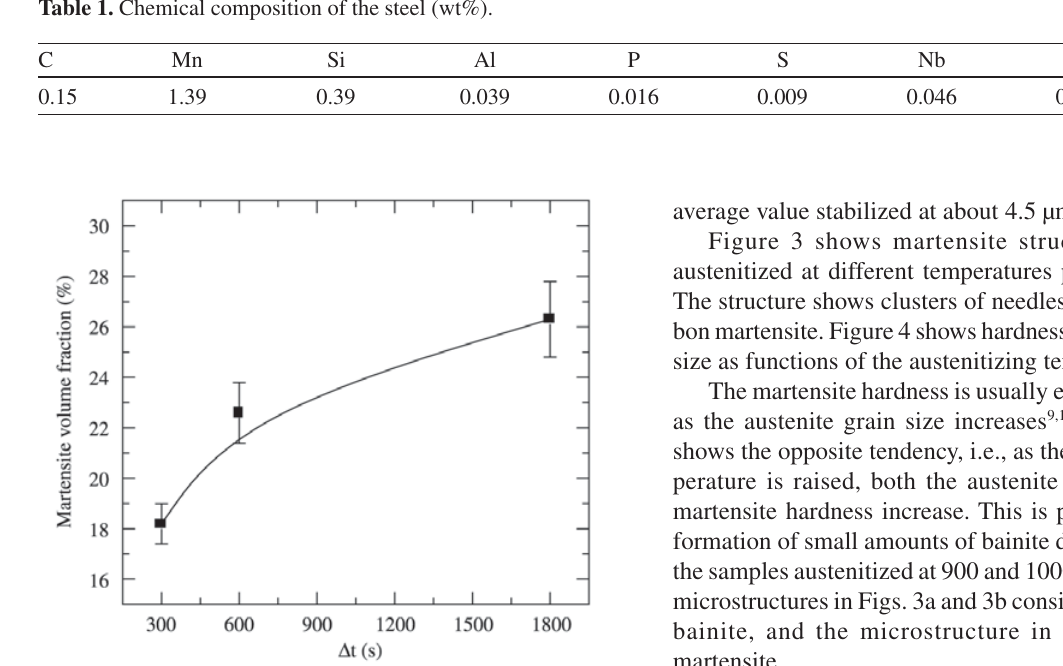
Figure 1. Martensite volume fraction as a function of the inter- critical treatment times.